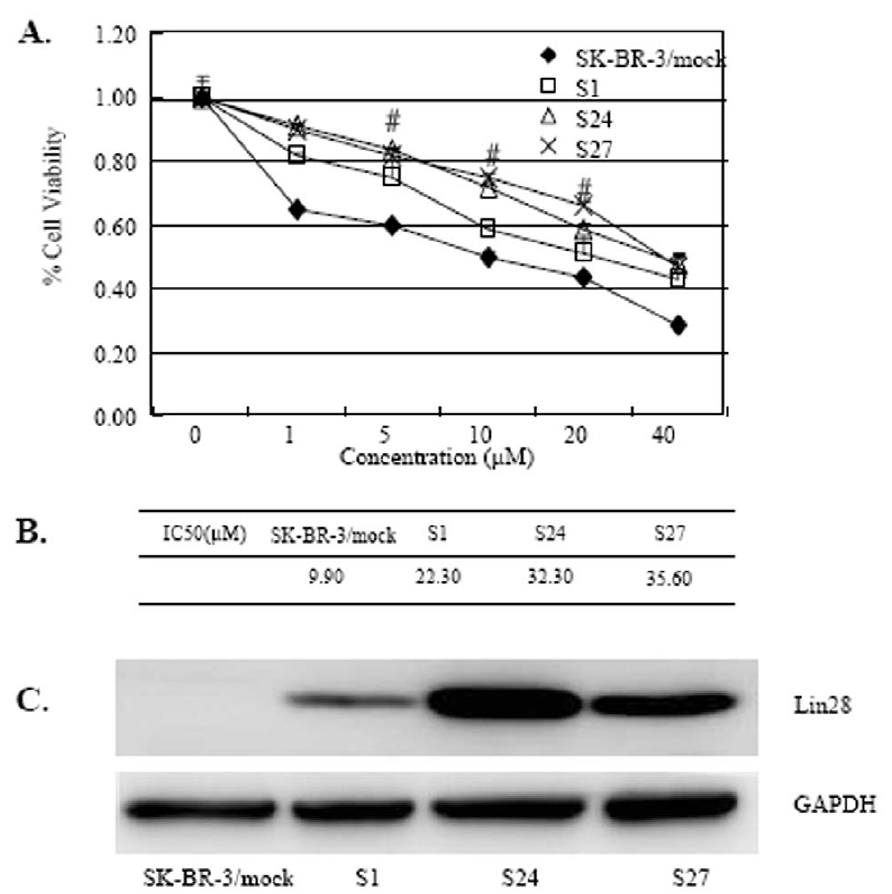
Figure 2. The SK-BR-3 cell line with stable Lin28 expression is relatively tolerant of paclitaxel treatment. (A). Cell viability of SK-BR-3 and its subclones S1, S24 and S27, which stably express Lin28. Cells were treated with paclitaxel for 48 h and cell viability was determined using the MTT assay. SK-BR-3 cells transfected with empty vector (SK-BR-3/mock) were used as a mock control. Each data point represents the mean SD of three independent experiments. Compared to mock controls, # , P , 0.05. (B). IC50 values for paclitaxel. (C). Lin28 expression in the indicated cell lines was determined by Western blot. GAPDH expression was used as a loading control. indicate that Lin28 expression was positively correlated with paclitaxel resistance.